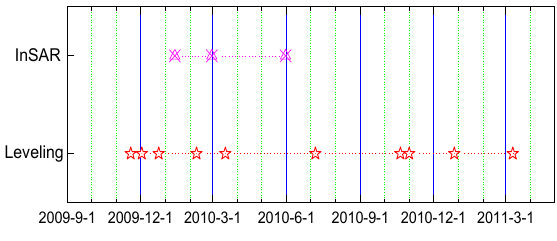
Figure 3. Observation dates of leveling and InSAR measurements